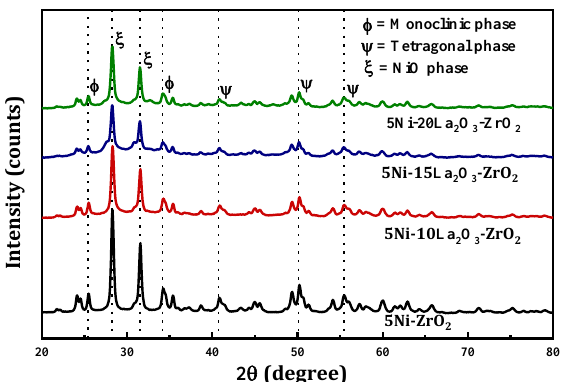
Figure 4. X-ray di ff raction (XRD) patterns for 5Ni-ZrO 2 and La 2 O 3 -promoted 5Ni-ZrO 2 Figure 4. X-ray diffraction (XRD) patterns for 5Ni-ZrO 2 and La 2 O 3 -promoted 5Ni-ZrO 2 catalysts .